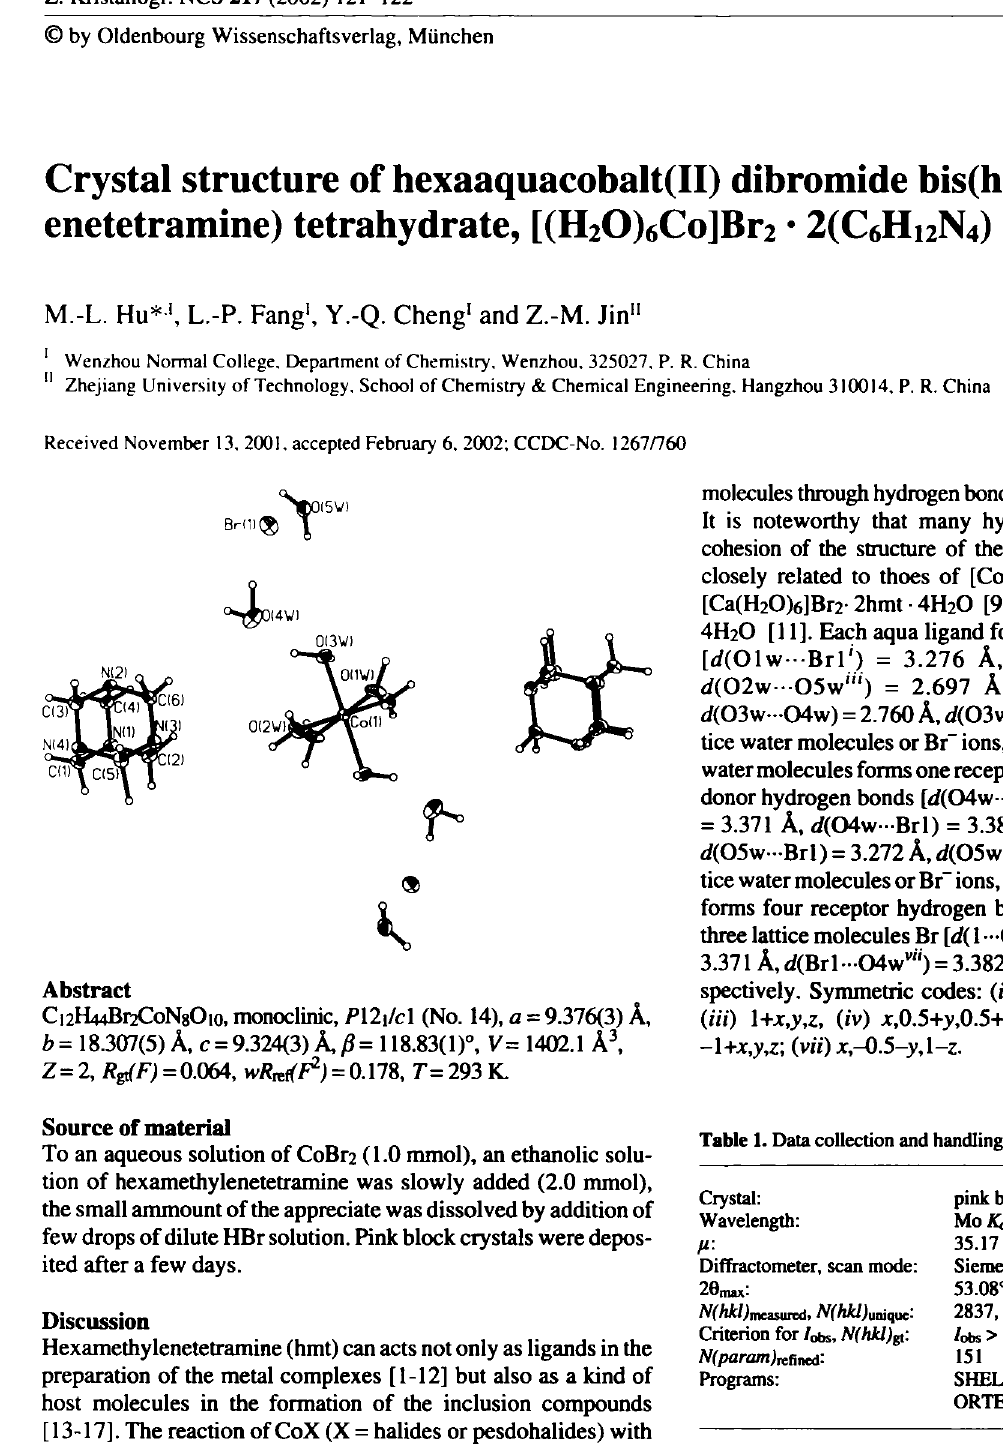
Table 2. Atomic coordinates and displacement parameters (in Â 2